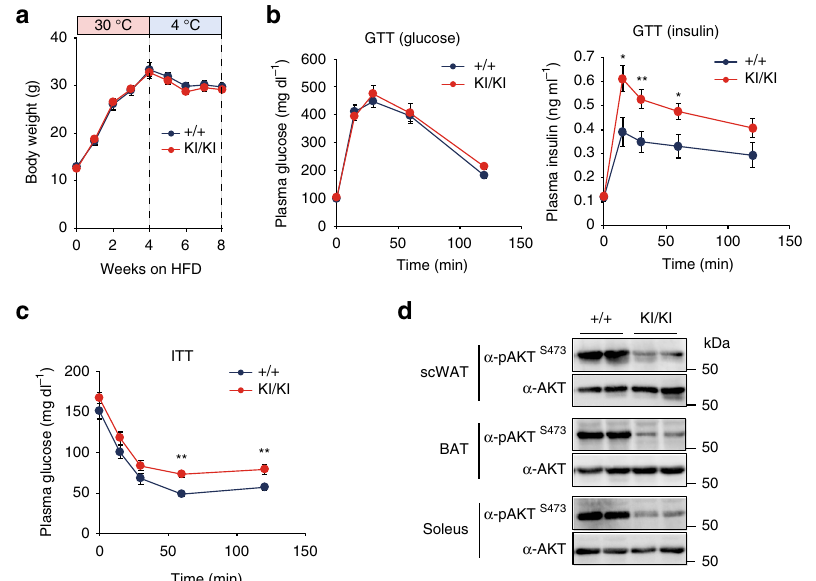
Fig. 7 Insulin resistance phenotype of Jmjd1a -S265A KI/KI mice. a Body weight changes. WT ( + / + ) and Jmjd1a -S265A KI/KI mice ( WT : n = 6; Jmjd1a - S265A KI/KI : n = 8) were fed on HFD for 4 weeks at 30 °C, and then switched to 4 °C for 4 weeks. b , c Glucose tolerance test (GTT) ( b ) and